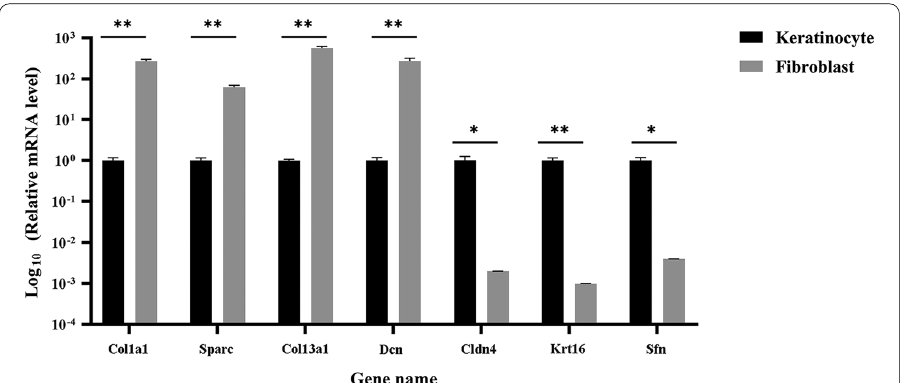
Fig. 5 Validation of skin disease related genes in RNA-Seq data using qRT-PCR. Seven skin disease related genes were selected to be analyzed by qRT-PCR. The relative mRNA expression was expressed as 2 − ΔΔCT . The Gapdh gene served as an internal reference to normalize the target gene expression. Mean *P < 0.05, **P <